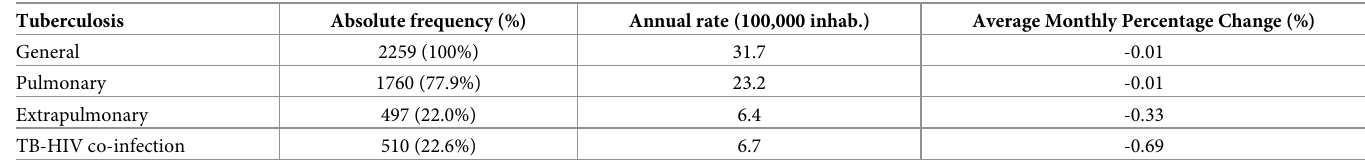
Table 1. Profile of tuberculosis cases according to classification and average monthly percentage variation of rates, Ribeir ã o Preto, S ã o Paulo, Brazil (2006–2017).